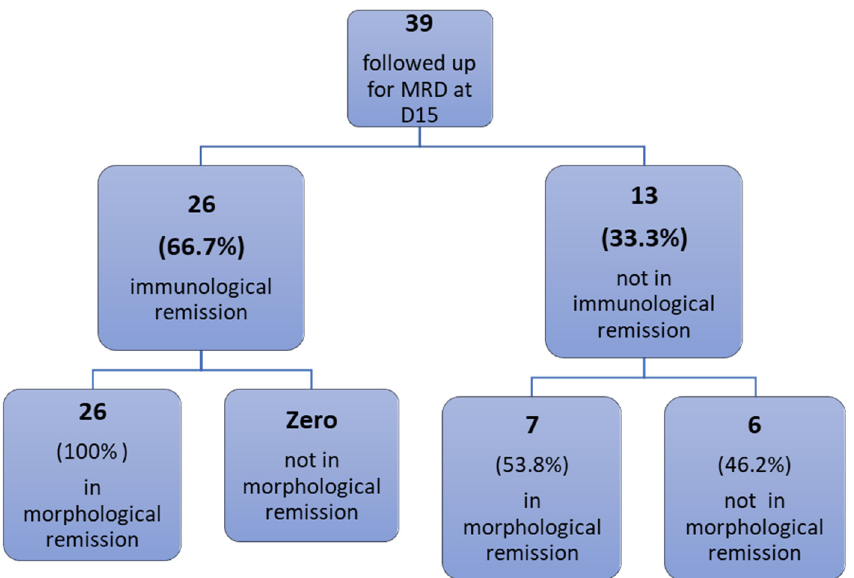
Figure 4. Distribution of patients with morphological remission versus immunological remission (negative MRD ≤ 0.01% by flowc ytometry) at day 15.